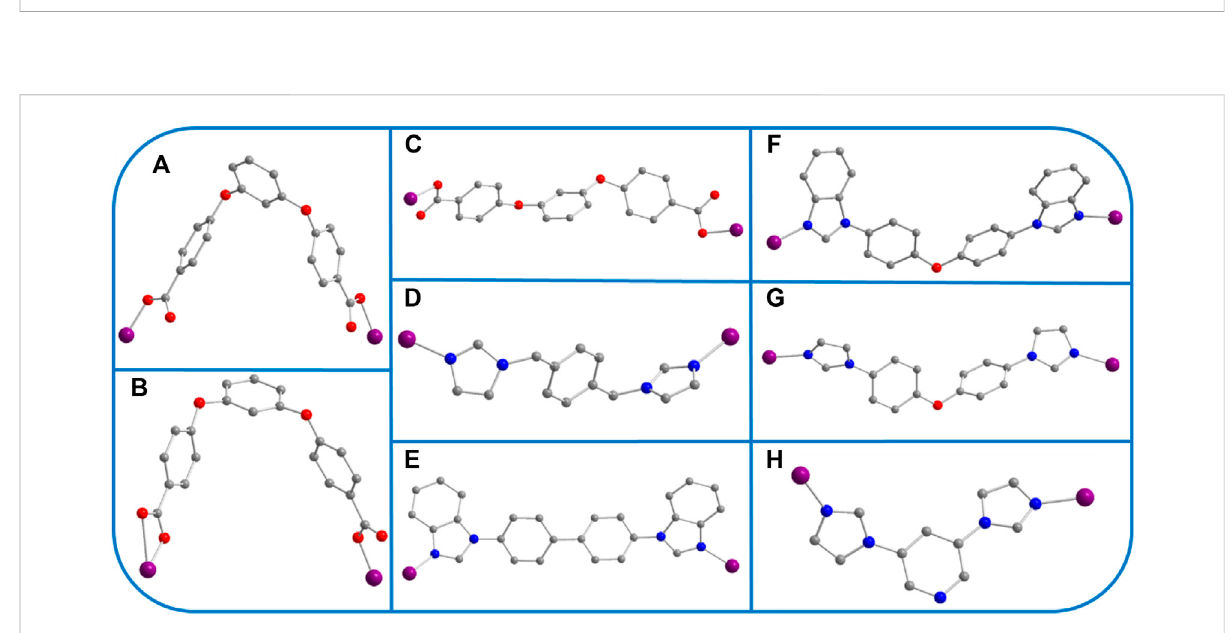
and by two nitrogen atoms from two independent 4,4 ′ -bbibp imidazole ligands. The three Co ions differ in the bond lengths and angles of Co – O/N and the bonding angle of O/N-donor